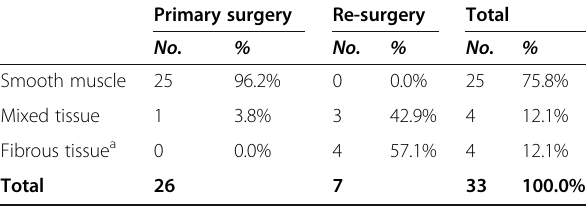
Table 1 Histopathological findings in primary and re-operated patients Primary surgery